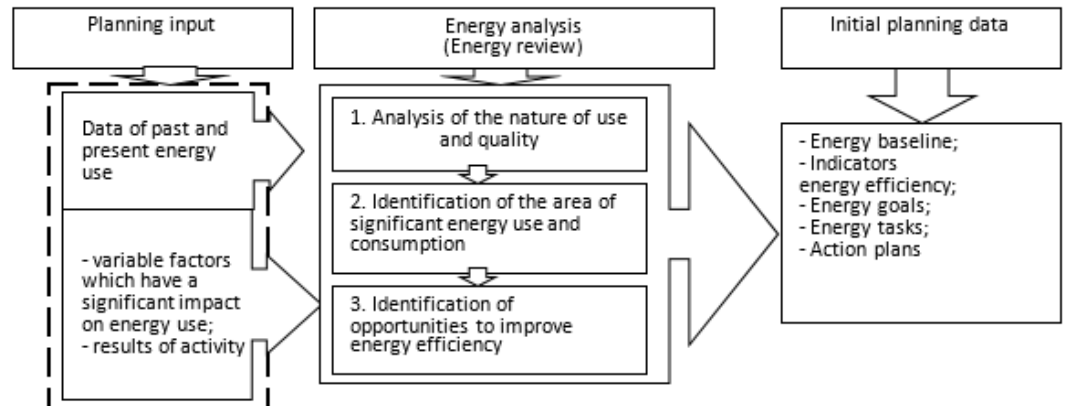
Fig. 3: Conceptual diagram of the energy planning process according to ISO 50001: 2018